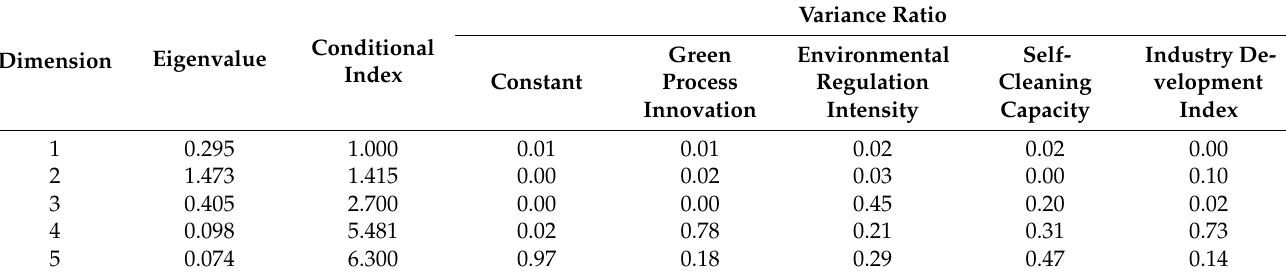
Table 2. Multicollinearity of core explanatory